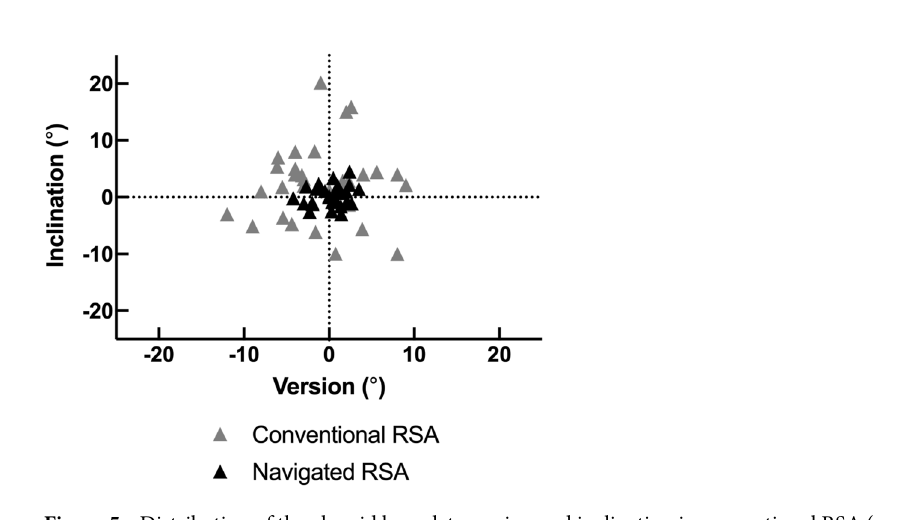
Figure 5. Distribution of the glenoid baseplate version and inclination in conventional RSA (grey triangles) and navigated RSA (black